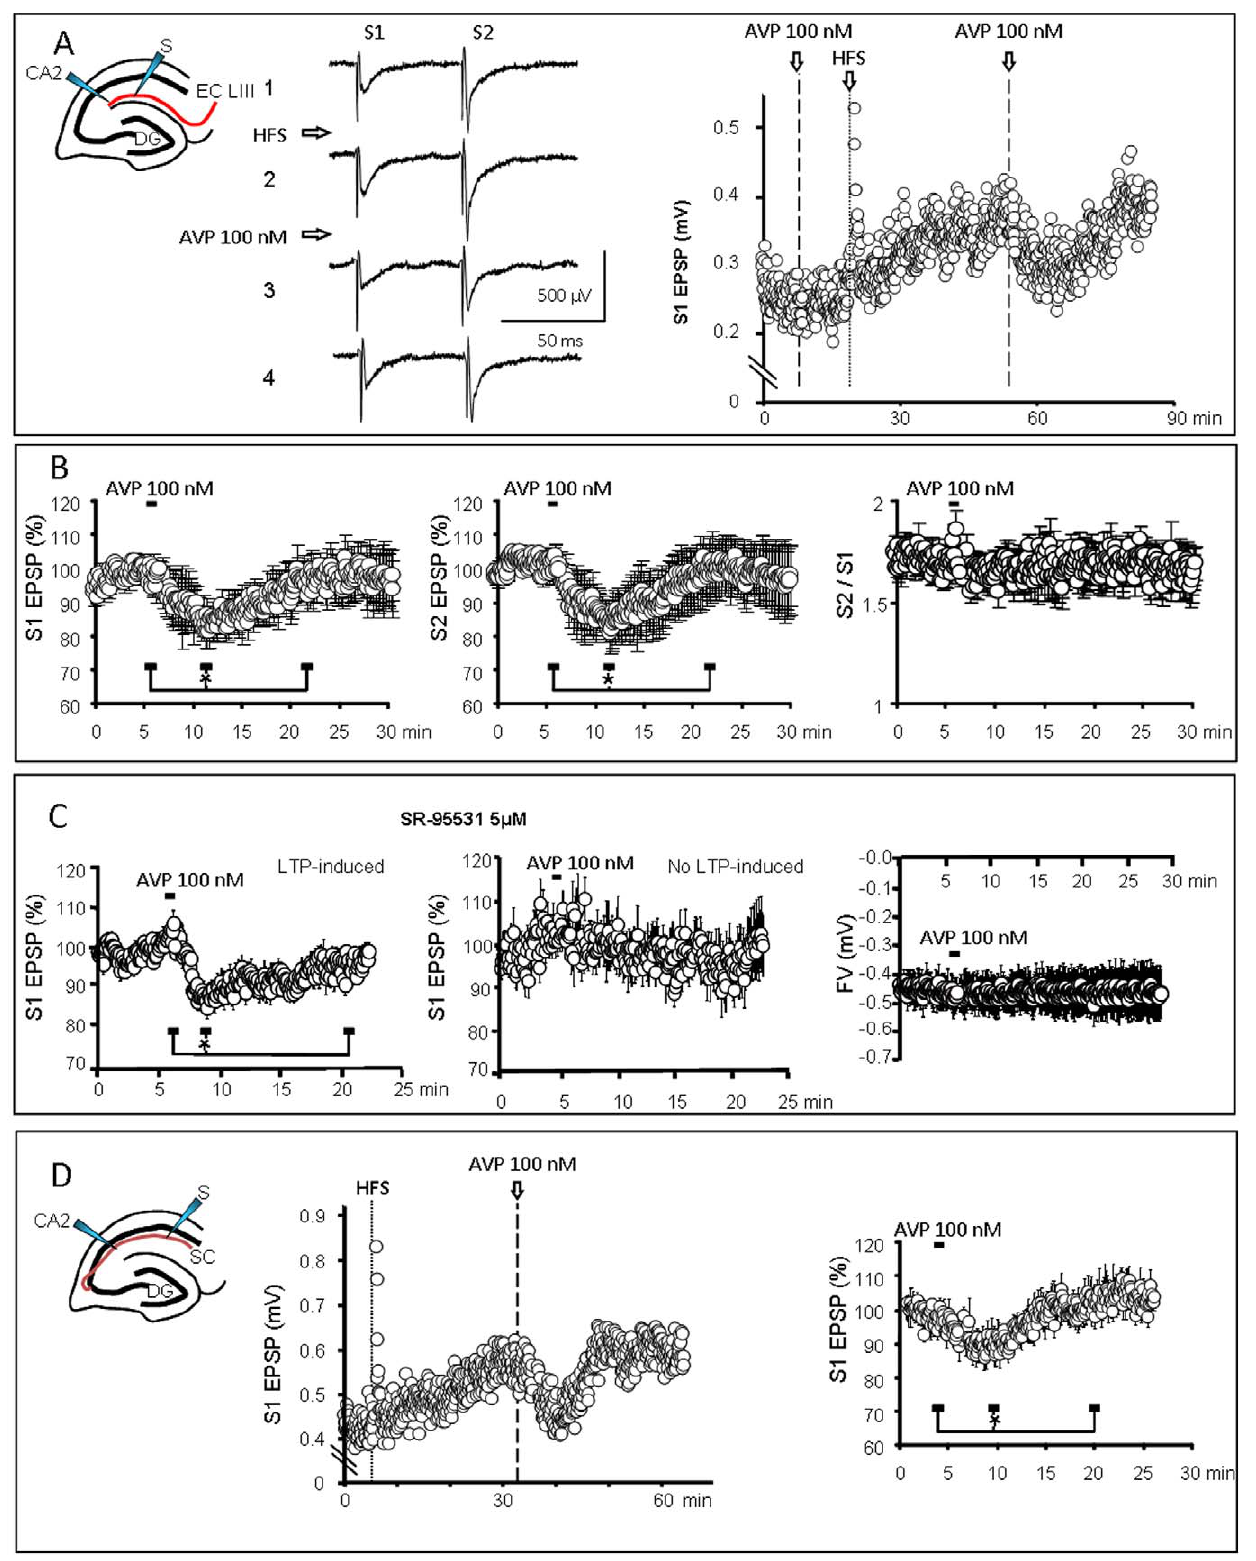
Figure 3. Vasopressin decreased the population fEPSP evoked by stimulation of LIII entorhinal fibers (EC LIII) and recorded in the CA2 dendritic field. A) Left : Typical recordings (left, 12 traces averaged over 1 min) of fEPSPs evoked by two successive stimulations before HFS (1) and during LTP before (2), during (3) and after (4) the response to AVP (100 nM ; 1 min). Note that the response to the second stimulation (S2) is larger than the first one (S1), indicative of a paired-pulse facilitation. Right, corresponding graph of the fEPSP amplitude vs. time. HFS induced a short-